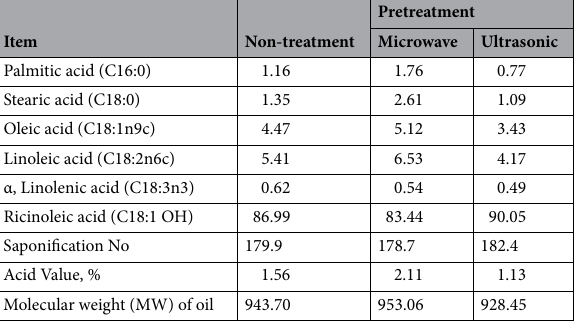
Table 1. Effect of pretreatment of castor seeds on the gas chromatography analysis compared with non- treatment.